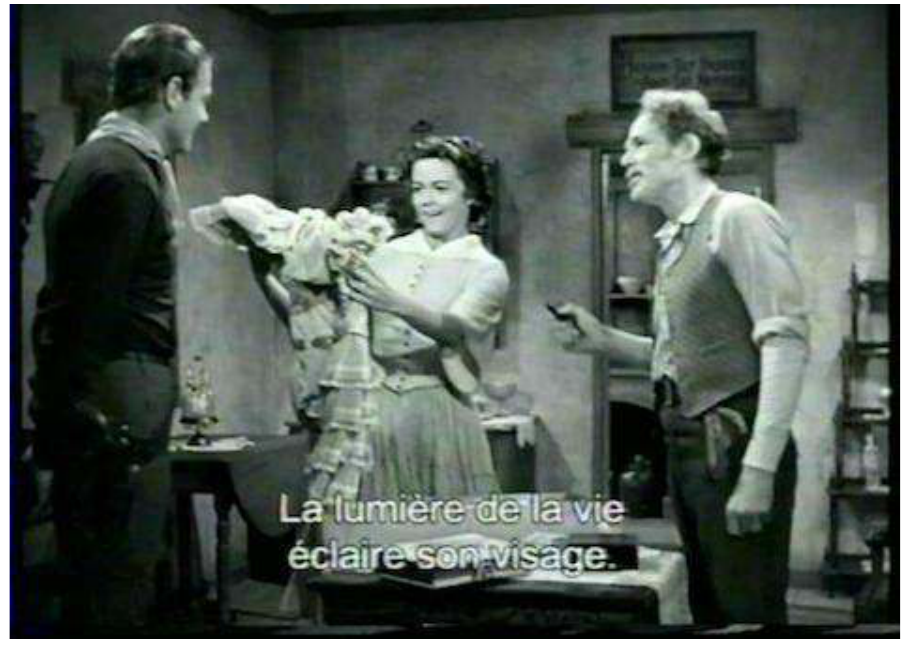
17 Before her hidden agenda is revealed, it is Julie Ann who stands for the “good” marrying-type girl, while Colorado appears as the wild woman with a past — a former saloon dancer, born from a White father and an Indian mother, who does not hesitate to tell Wes she wants him. When Wes asks her how she’s understood so quickly that he courted Julie Ann because she reminded him of his dead fiancée, Colorado simply replies “I’m a woman”, asserting intuition as part of the “essence” of her sex. Colorado may proclaim her womanhood in a very conservative way but she certainly subverts the 1940s codes of femininity. She cooks, but refuses to serve his meal to Reno (John Archer), the man she travels with. She is brave enough to remove a bullet from Wes’s shoulder and cauterize the wound. Wounded, weak and bed-ridden, Wes is treated by Colorado who operates on him with scissors and clamps. While the Winslows squeamishly look away during the procedure, Colorado is gazing straight into Wes’s eyes, in a scene that stands as the most erotic moment in the film, with the woman symbolically on top and penetrating the male body (see Figures 15 and 16). Colorado defies men by appropriating their codes: she refuses to do their bidding; she spits at the man who attempts to bribe her into selling out Wes (a behaviour that recalls Scarlett’s spontaneous reaction of throwing dirt at the man who came to buy Tara); she holds them at gunpoint (see Figure 17) and does not hesitate to shoot to defend the man she loves, till death do them part , à la Bonnie and